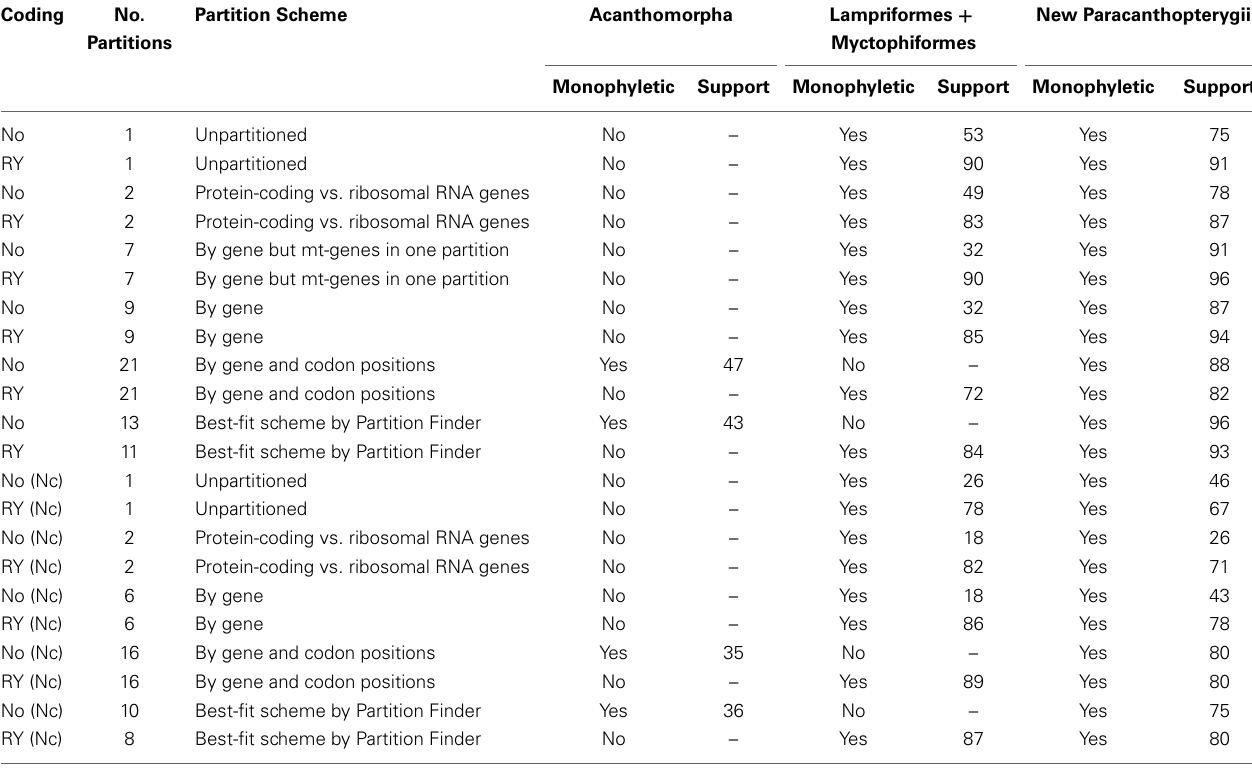
Table 3 | Summary of the 22 unpartitioned and partitioned RAxML analyses conducted based on four data matrices with and without mitochondrial genes, and with and without RY coding of the third codon positions for protein coding genes for this